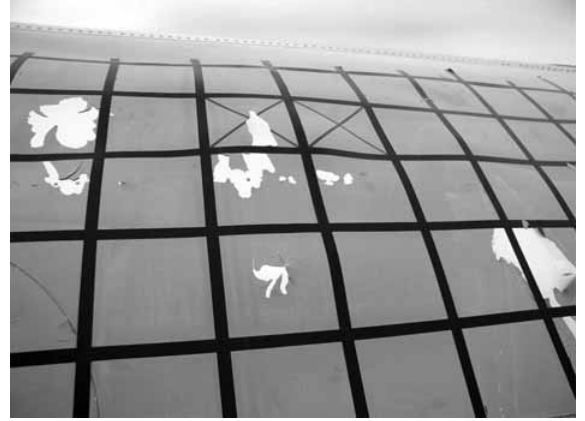
Fig. 18. Outer skin view after basic shield test.